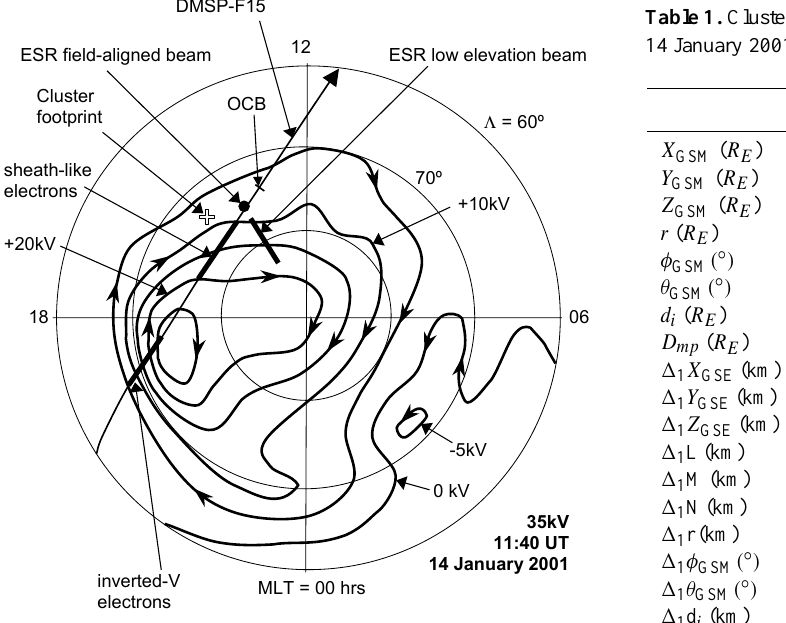
Table 1. Cluster spacecraft coordinates and separations at 11:23